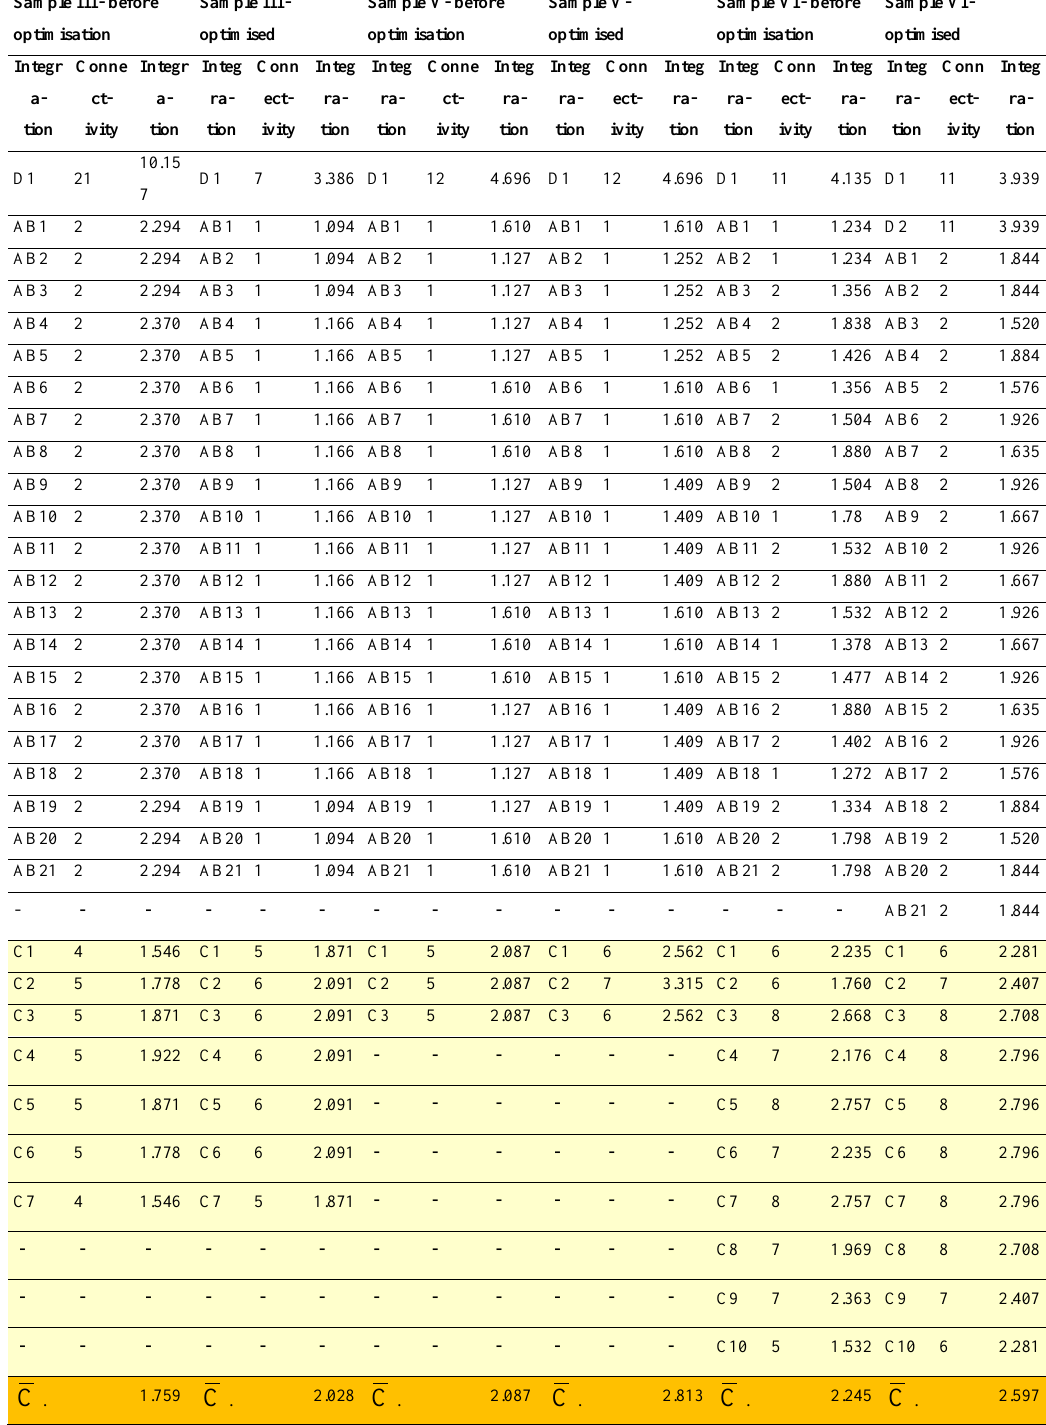
Table 7 Connectivity and integration of optimised